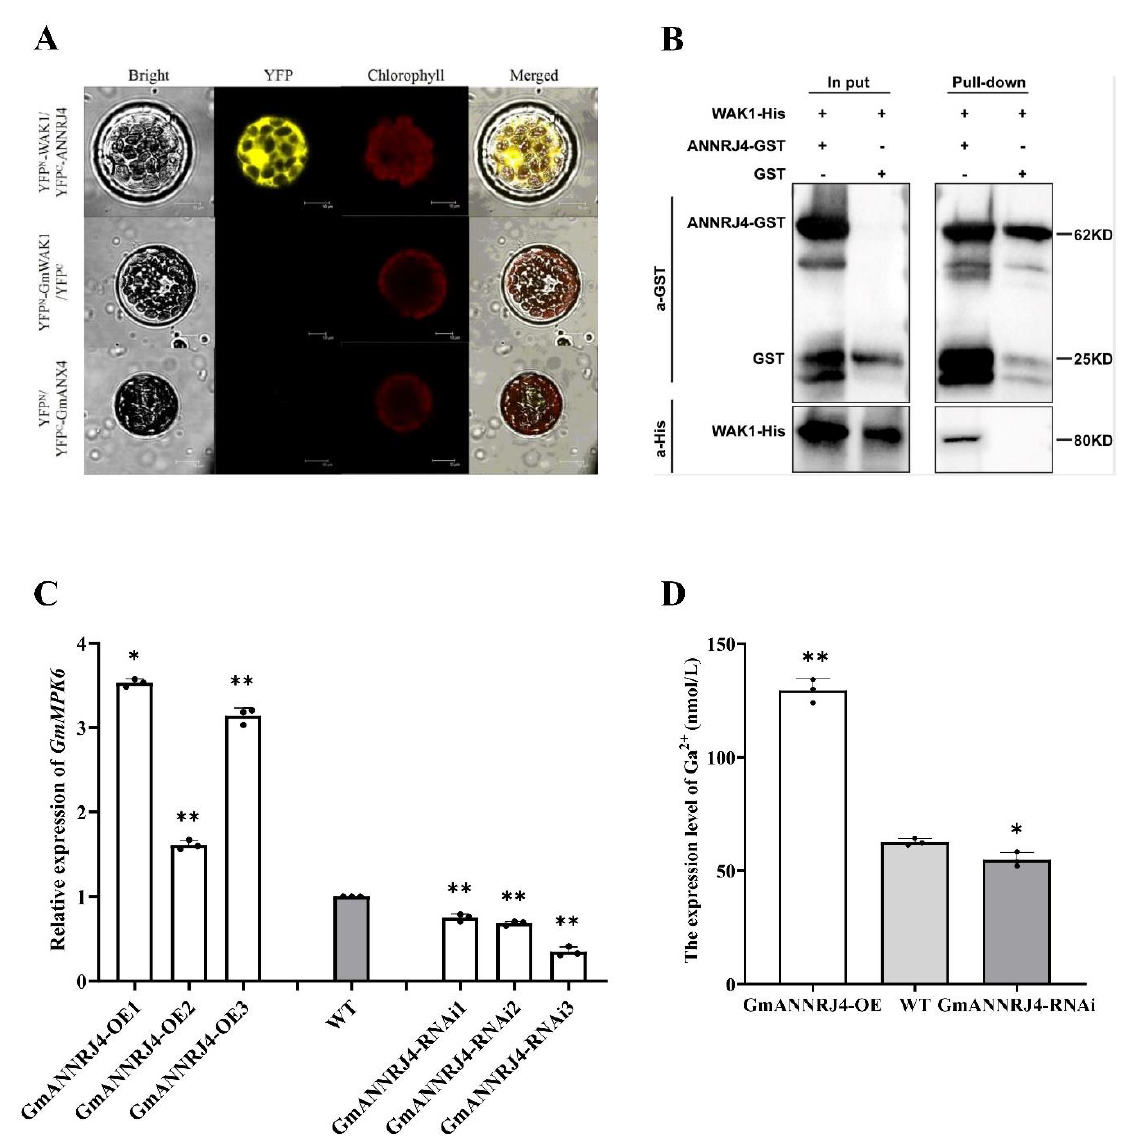
Figure 6. Interaction of GmWAK1 with GmANNRJ4. ( A ) Results of Bimolecular fluorescence complementation (BiFC) analysis of interaction between GmWAK1 and GmANNRJ4 in Arabidopsis protoplast cells. Yellow fluorescent protein (GFP) fluorescence (yellow) was observed by confocal laser microscopy. Scale bars: 10 µ m. ( B ) Interaction between GmWAK1 and GmANNRJ4 as revealed by pull-down assay. ( C ) Results of analysis of intracellular Ca 2+ concentration regulation. Calcium ion concentration in cytoplasm of hairy roots of GmANNRJ4 transgenic soybean ( D ). Relative expression of GmMPK6 in GmANNRJ4 transgenic soybean plants. Results of analysis of relative expression of GmMPK6 in GmANNRJ4 transgenic soybean plants by qRT − PCR. Three biological